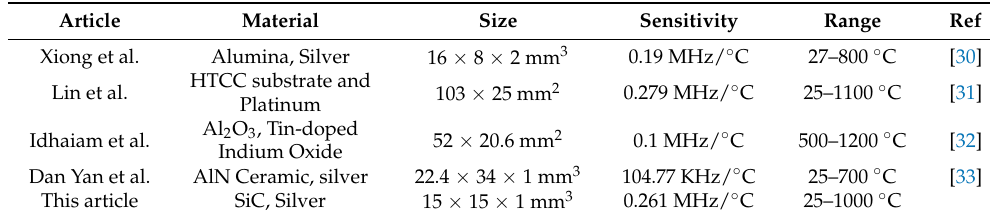
Table 3. Comparison of various wireless passive temperature sensors in the